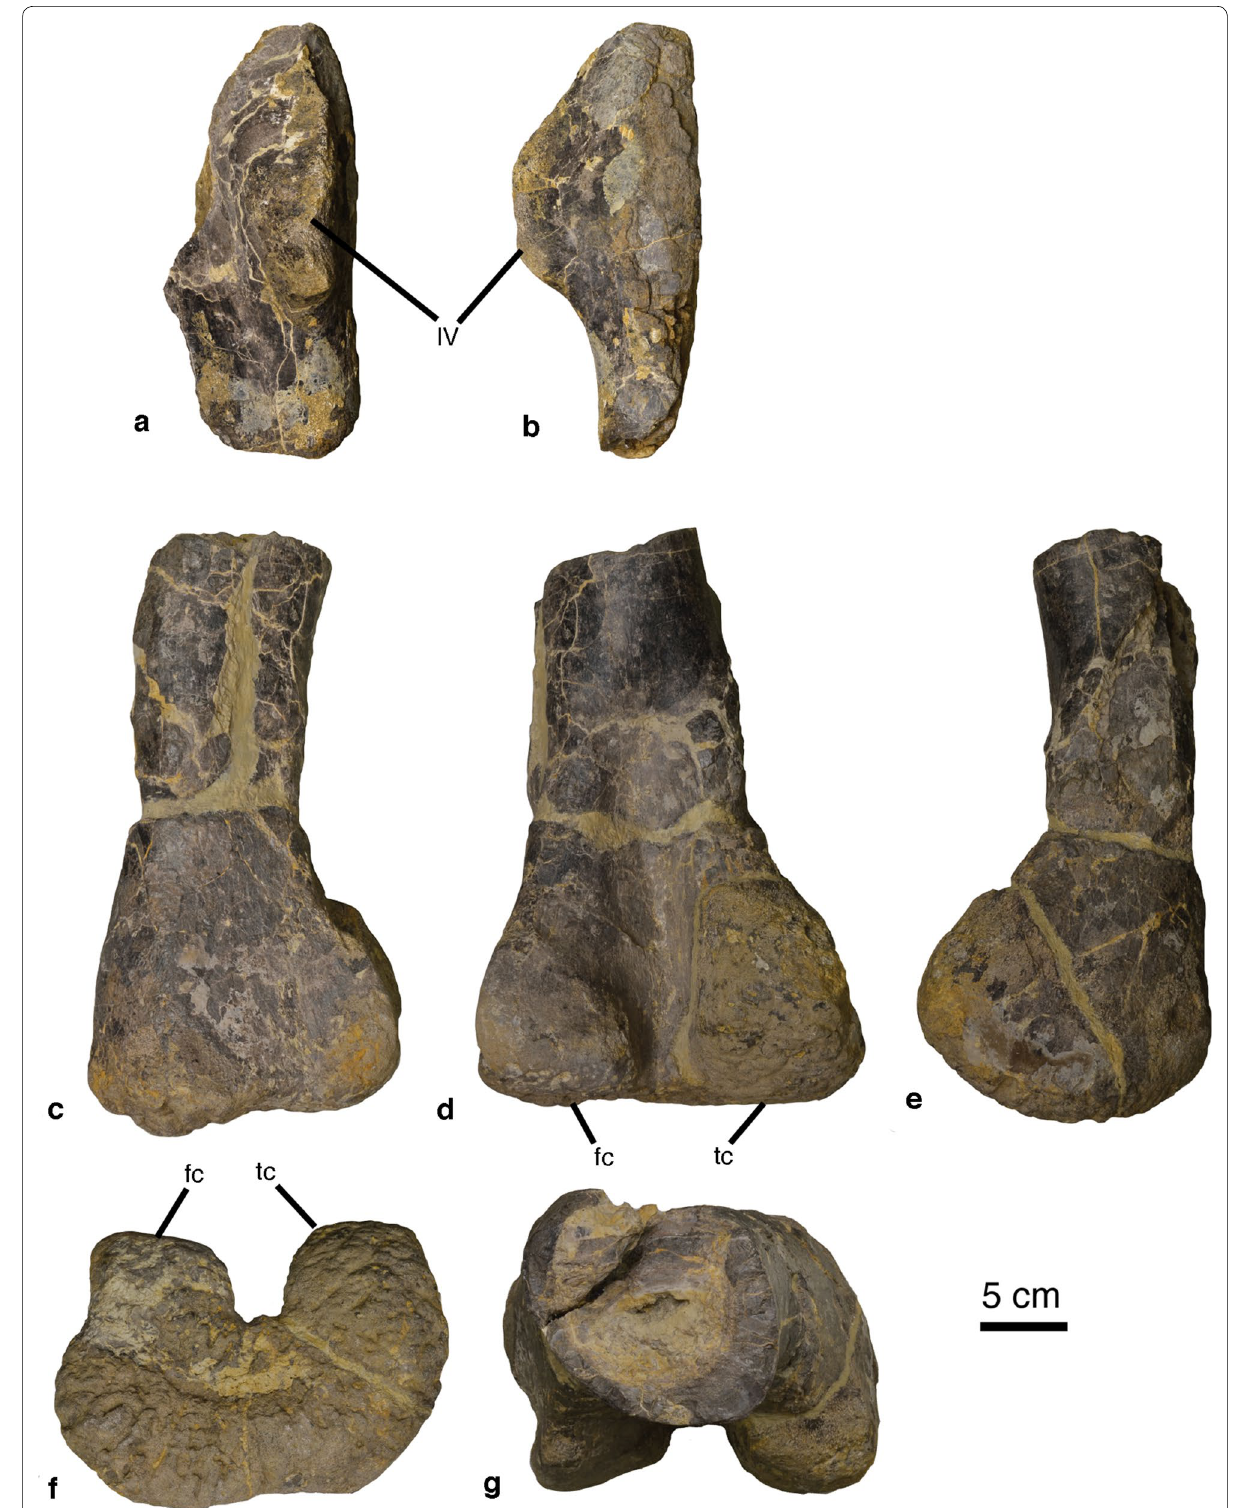
Fig. 10 Partial left femur of Schleitheimia schutzi n. gen., n. sp., PIMUZ A/III 551. a , b Fragment of the mid-shaft in posterior ( a ) and medial ( b ) view; c – g distal end in lateral ( c ), posterior ( d ), medial ( e ), and distal ( f ) views, and proximal view of proximal break ( g ). Abbreviations: IV, fourth trochanter; fc, fibular condyle; tc, tibial condyle. Scale bar equals 5